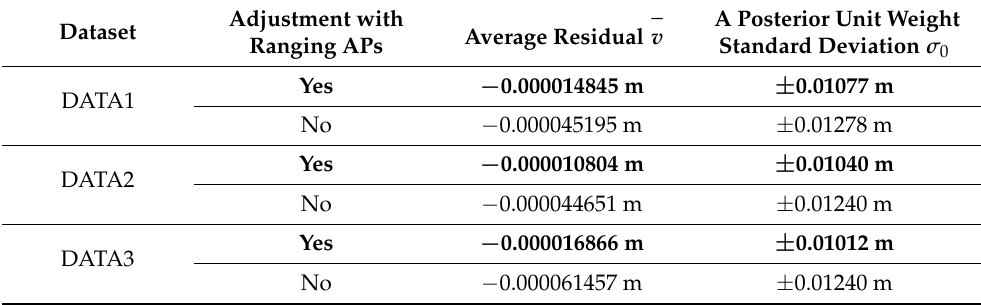
Table 10. Average residual and unit weight standard deviation for the three datasets using least- squares adjustment, with and without ranging